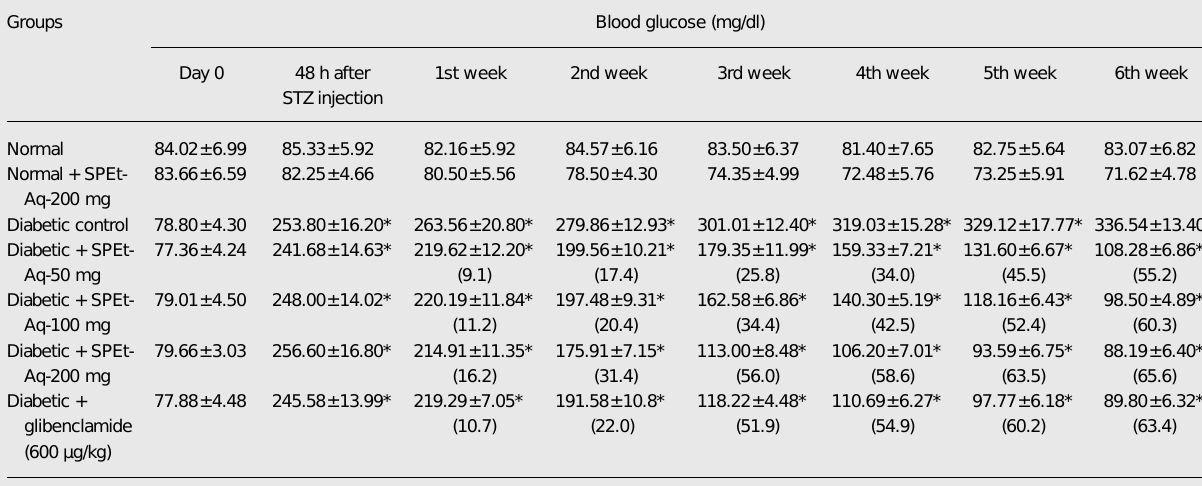
Table 1. Effect of 6 weeks of treatment with an aqueous extract of Scoparia dulcis on glucose levels of normal and diabetic rats. Groups